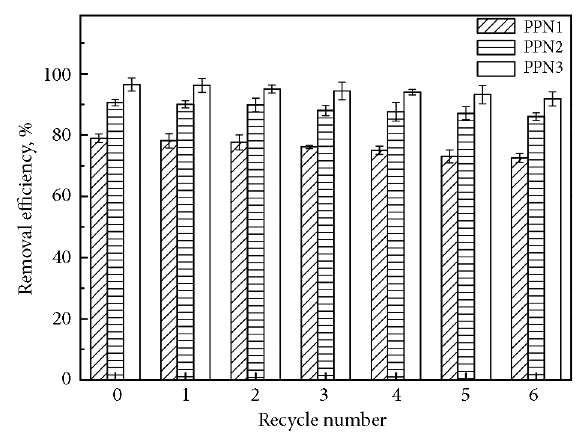
Figure 6. Cr(VI) removal with recycle numbers for the regenerated PPN. Reaction conditions: 50 mL of 20 mg L −1 Cr(VI) solution, pH = 3.88, reaction time 120 min, and solution temperature 298 K